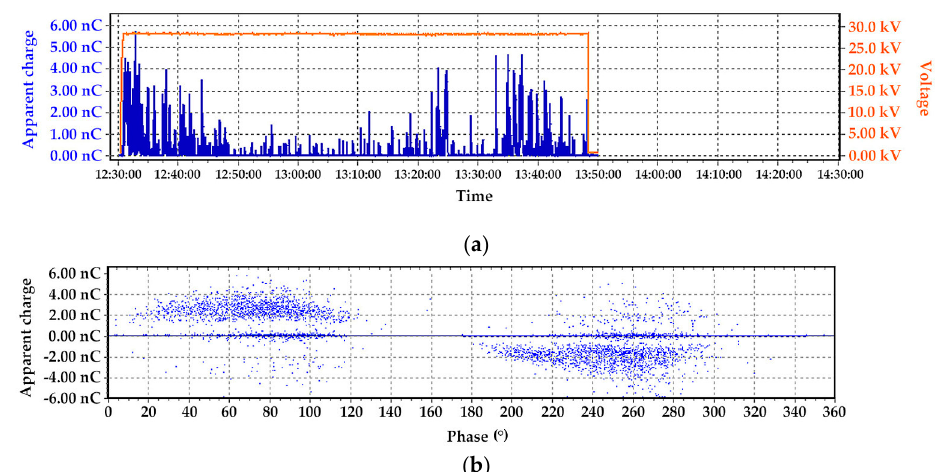
Figure 24. Measurement results obtained with conventional electric method: ( a ) instantaneous value of apparent charge q , ( b ) PRPD pattern.